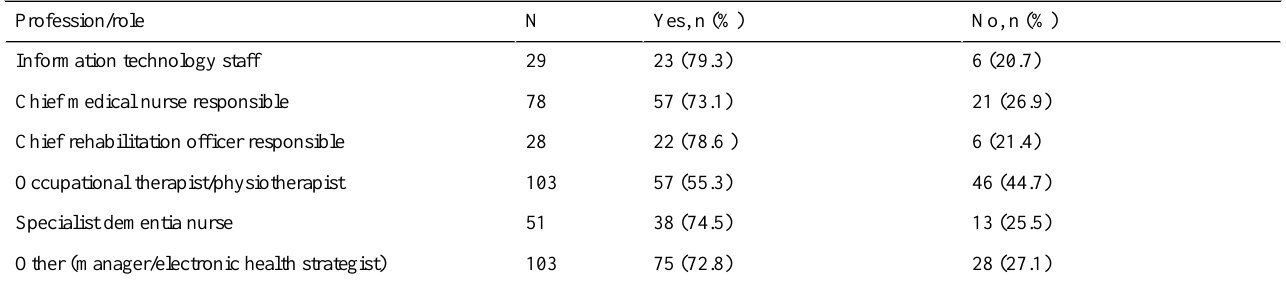
Table 4. Distribution of responses regarding continuous evaluation of implemented welfare technology in relation to profession/role